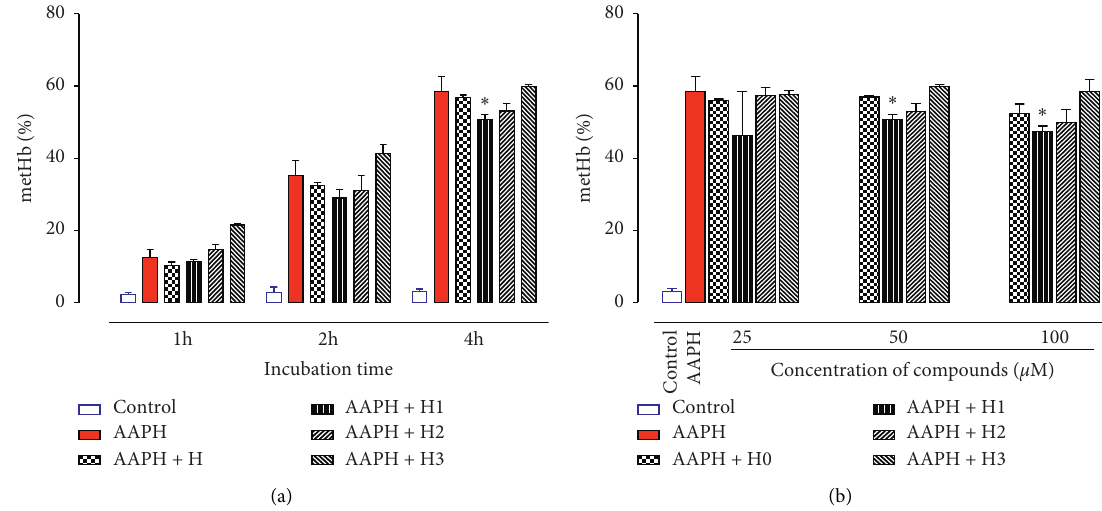
Figure 4: Duration of the protective effects of piperine derivatives on AAPH-induced hemoglobin oxidation in erythrocytes and time curves. (a) Time curves of the protective effects of piperine derivatives on AAPH-induced hemoglobin oxidation at a concentration of 50 μ M. (b) The relationship between the protective effects of piperine derivatives at different concentrations and AAPH-induced he- moglobin oxidation after 4h incubation.